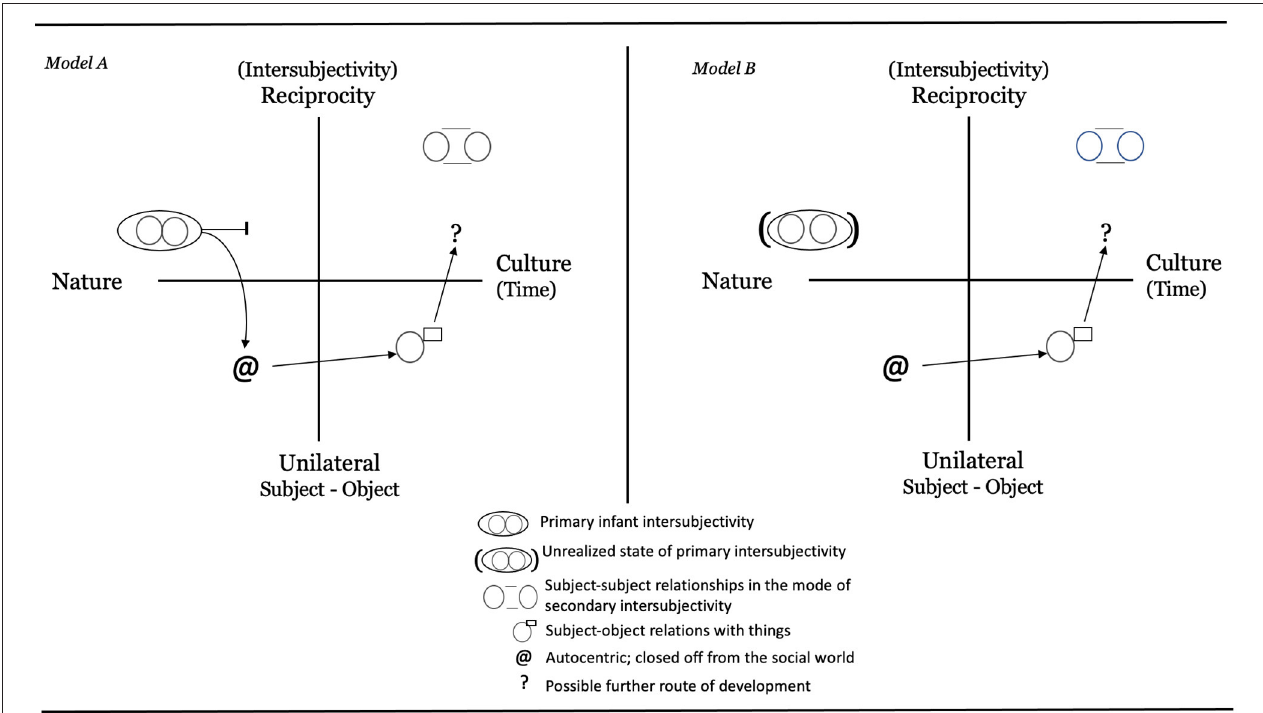
FIGURE 1 | Two theoretical models describing the infants state of mind with respect to intersubjectivity at birth for a child later diagnosed with autism. Explanations: Model A describes an initially typical development, the infant is born with a capacity of primary intersubjectivity, autism emerges later. Model B describes a starting state that is different from the beginning. A child within the autism spectrum does not have the same capacity to intersubjectivity at birth, the mind is not dialogical from the start (Adopted from Heimann, 1998, p. 100–101. Reprinted with